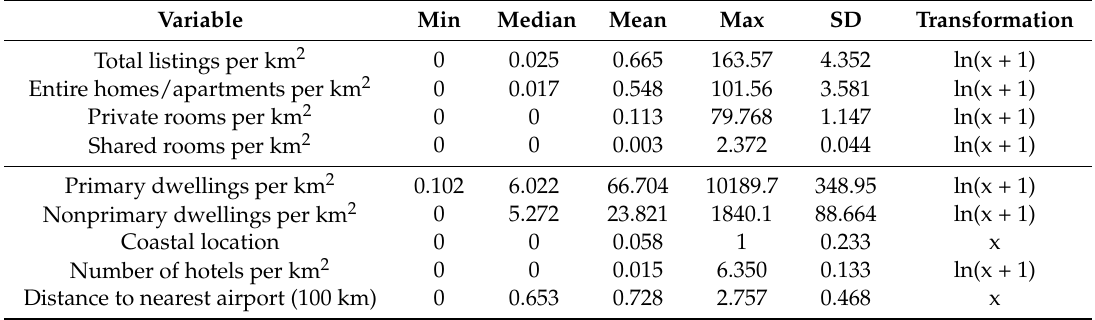
Table A2. Descriptive statistics of the variables used in models for municipalities (N = 8124).